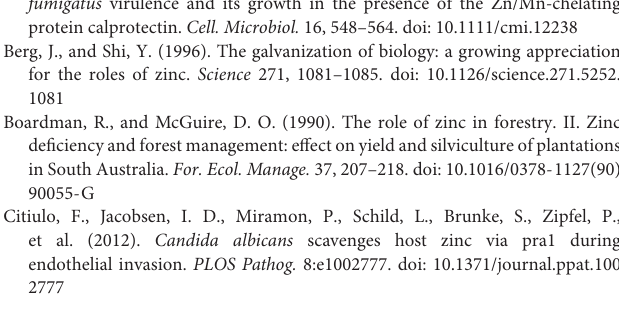
FIGURE S1 | Functional complementation of the zinc-uptake-deficient yeast strain (cid:49) zrt1 (cid:49) zrt2 by SlZRT1::EGFP. Wild type (WT) and mutant yeast cultures with an OD 600 = 1 were 10-fold serial diluted (10 0 , 10 − 1 , 10 − 2 , and 10 − 3 ) and spotted